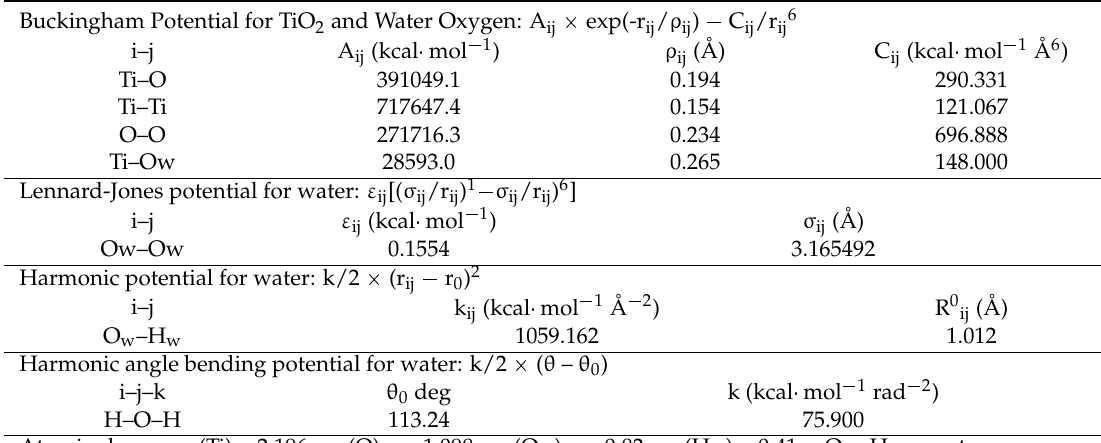
Table 1. Force-field parameters. Taken from [24] (titania) and [25] (water), with titania-water interactions as described in [16].